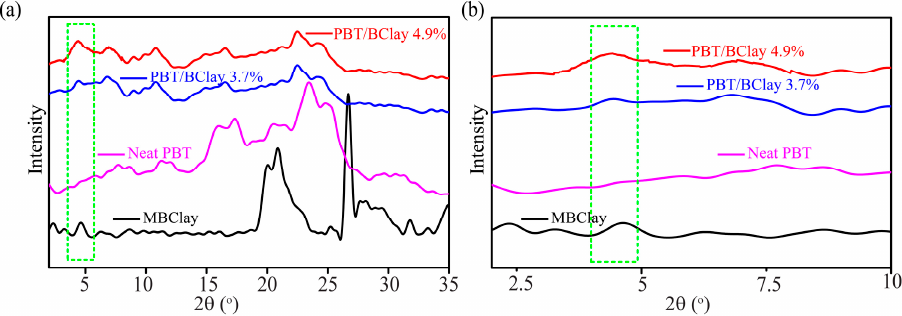
Figure 3. XRD patterns for the MBClay, neat PBT, and PBT/MBClay nanocomposites: ( a ) in the range of 2 θ between 2 ◦ to 35 ◦ ; ( b ) in the range between 2 ◦ to 10 ◦